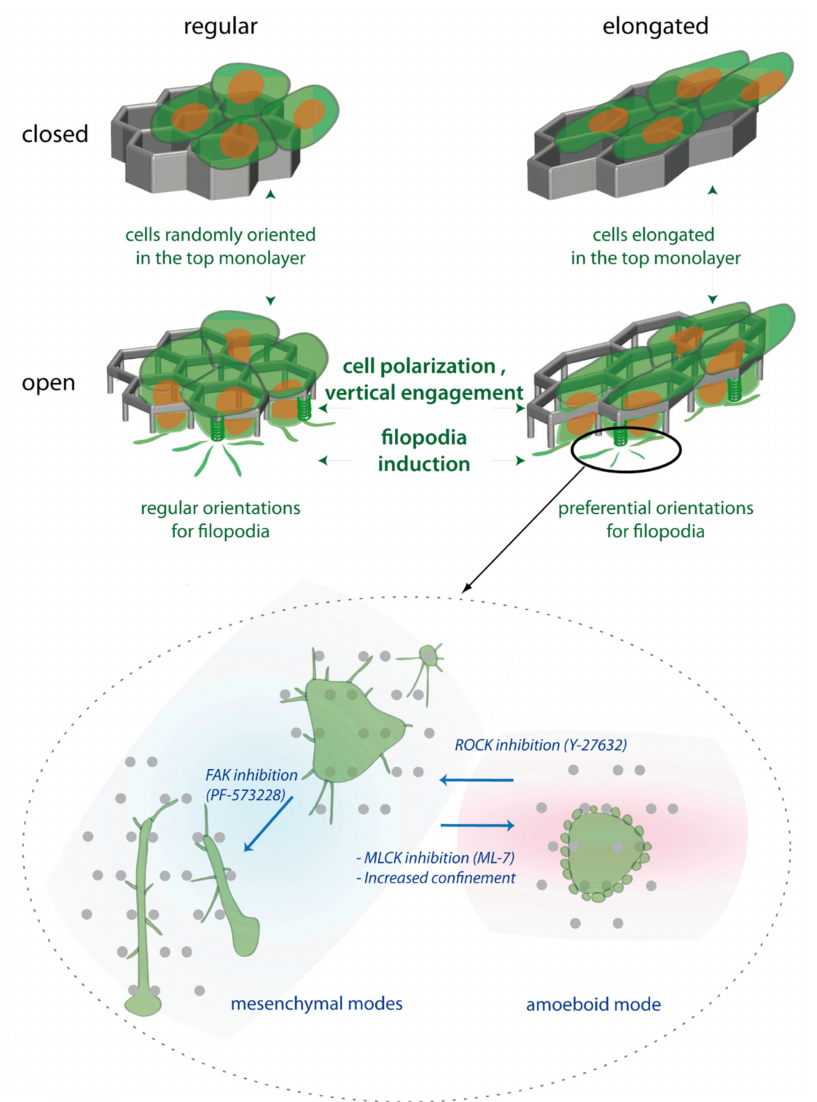
Figure 10. Recapitulative scheme of the global cell behaviour in the microstructures. ( Top ) Organisa- tion of endothelial HUVECs in function of the elongation of hexagons in the horizontal plane, and of the open or closed nature of the microstructure. These two characteristics modulate the orientation of the top monolayer, the vertical engagement and the induction of filopodia, and the orientation of the exploratory filopodia. The vertical cell polarization and the induction of filopodia are hallmarks of tip cell phenotype, but occur independently of VEGF. ( Bottom ) Zoom of the different protrusive modes present in the bottom plane (pillars) of open elongated structures, and transitions between